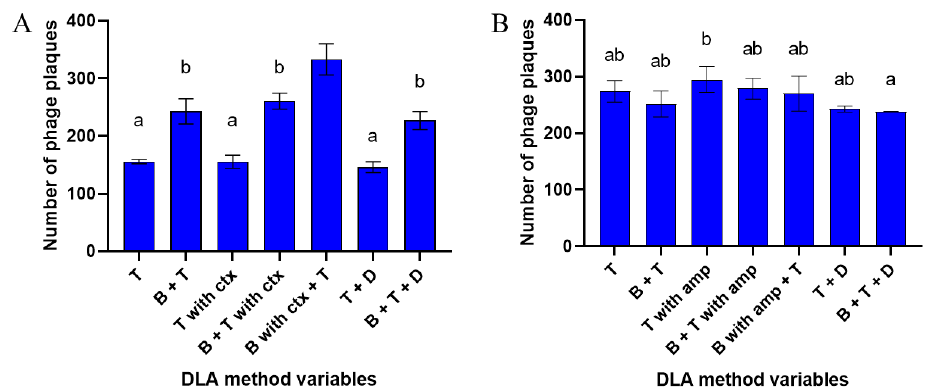
Figure 2. The total number of phage plaques per plate depending on the DLA method variable with the addition of ( A ) cefotaxime or ( B ) ampicillin. Top agar was marked as “T”, bottom agar as “B”, antibiotic disk as “D”, cefotaxime and ampicillin as “ctx” and “amp”, respectively. Phage was added to the top agar layers. Vertical bars indicate means ± SD. a, b—means sharing the same superscript are not significantly different from each other at p ≤ 0.05.